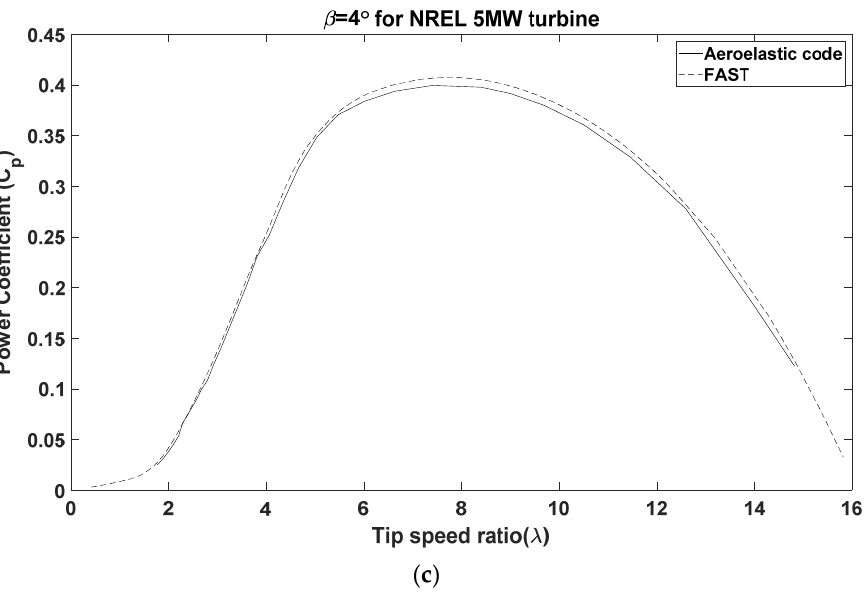
Figure 8. Power coefficient of the NREL 5MW wind turbine as a function of tip speed ratio in three different pitch angles. A comparison between the aeroelastic code and FAST ( a ) β = 0 ◦ . ( b ) β = 2 ◦ . ( c ) β = 4 ◦